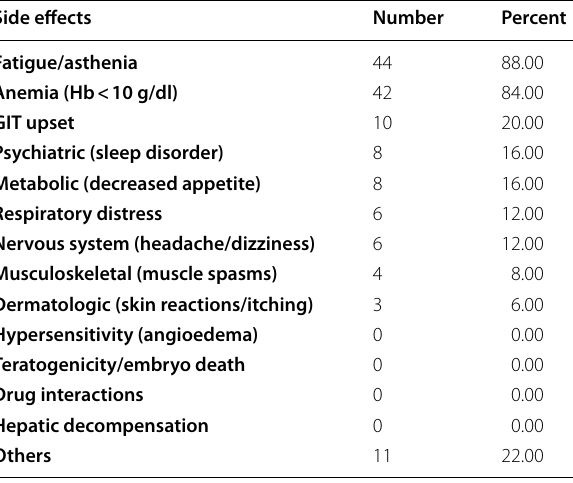
Table 5 Prevalence of different known side effects of DAA therapy among the studied group